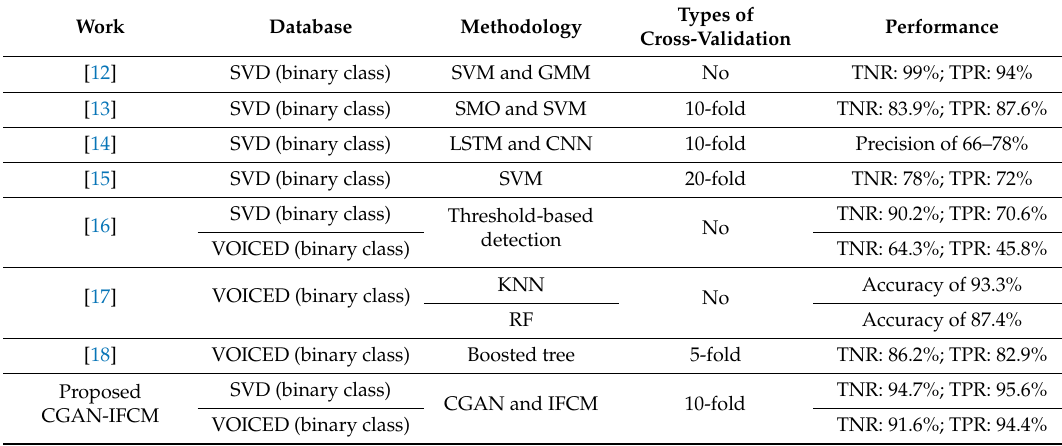
Table 9. Performance comparison between CGAN-IFCM and existing works on the binary detection model for voice disorder